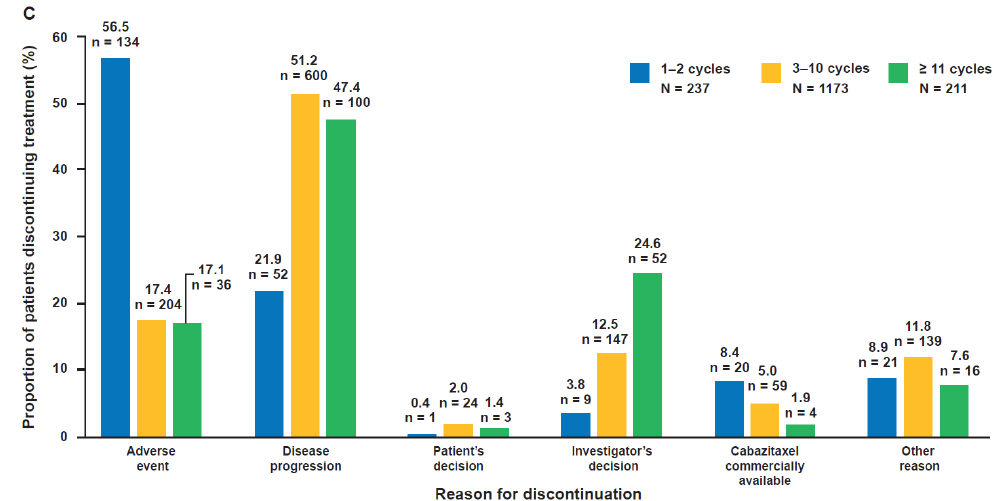
Figure 2. Reasons for treatment discontinuation according to the number of cabazitaxel treatment cycles received across the CUP/EAP and CAPRISTANA studies: ( A ) ≤6 cycles vs. >6 cycles; ( B ) ≤4 cycles vs. >4 cycles; ( C ) 1–2 cycles vs. 3–10 cycles vs. ≥11 cycles. CUP: compassionate use program; EAP: expanded access